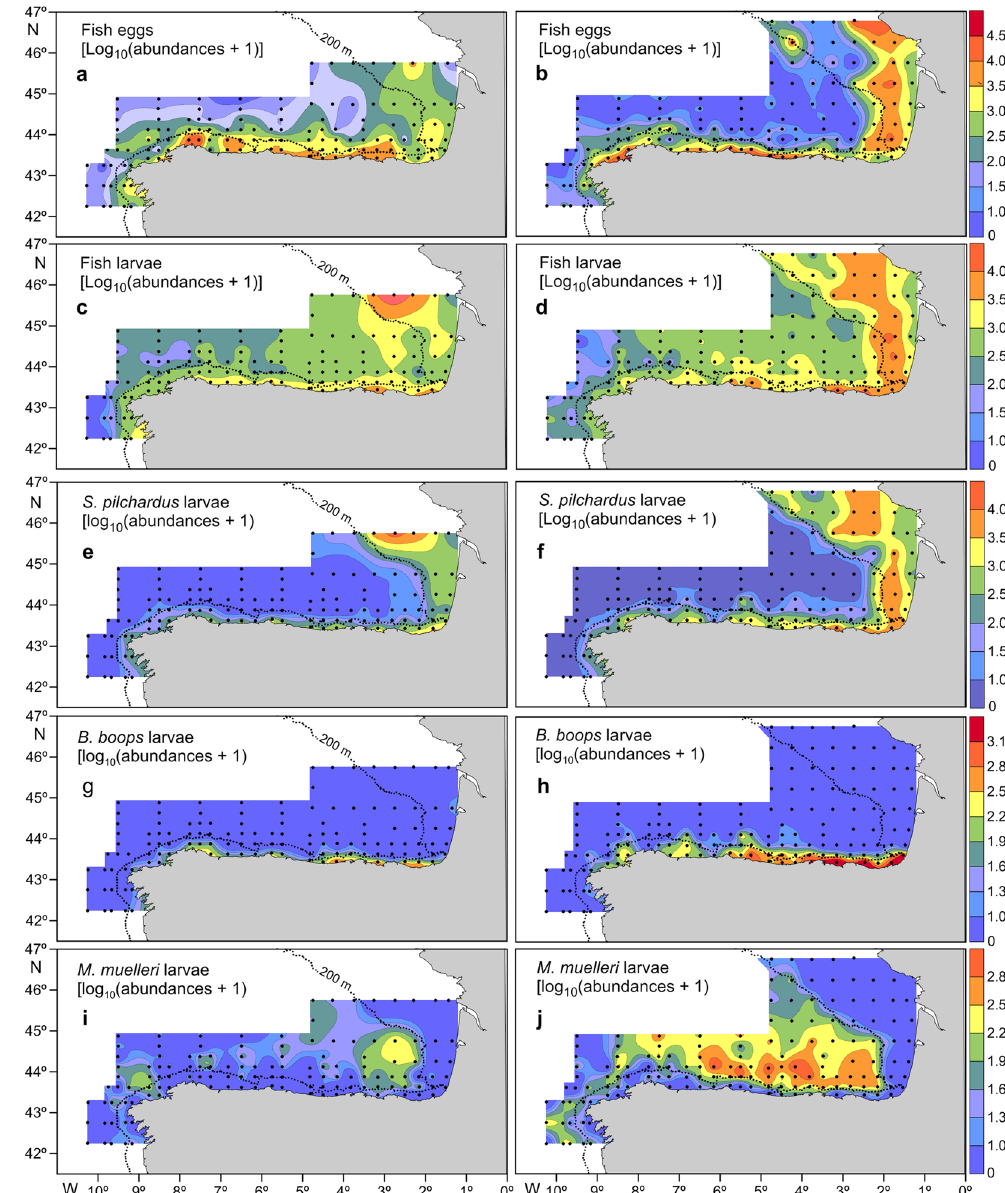
Figure 4. Horizontal distribution of: ( a ) Fish eggs during the CAREVA cruise (CC); ( b ) Fish eggs during the JUREVA cruise (JC); ( c ) Fish larvae during the CC; ( d ) Fish larvae during the JC; ( e ) Sardina pilchardus larvae during the CC; ( f ) S . pilchardus larvae during the JC; ( g ) Boops boops larvae during the CC; ( h ) B . boops larvae during the JC; ( i ) Maurolicus muelleri larvae during the CC; ( j ) M . muelleri larvae during the